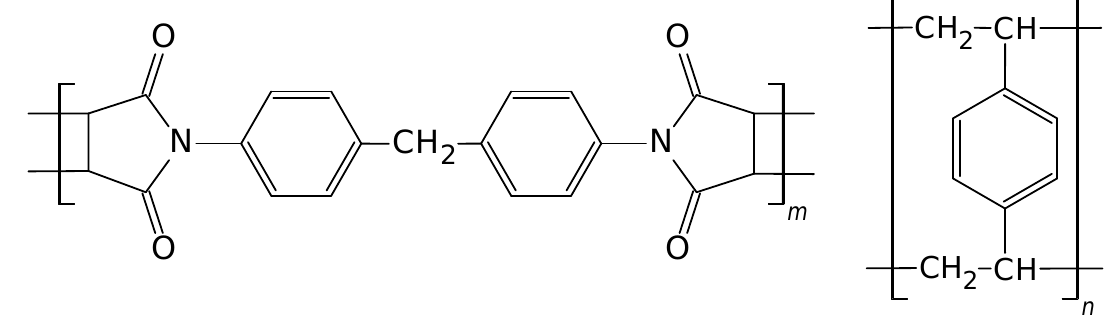
Figure 1. The chemical formula of 4, 4′ -bis(maleimidodiphenyl)